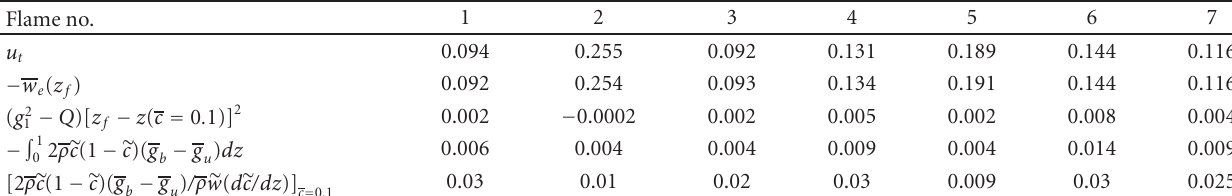
Table 3: Turbulent burning